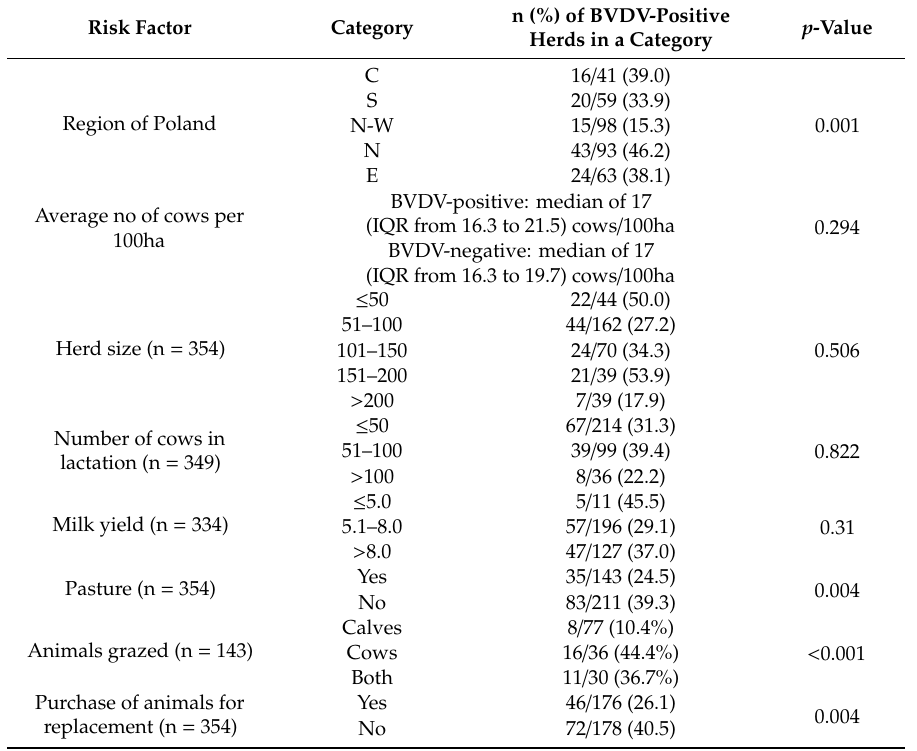
Table 3. Estimation of the factors considered to be a “risk” for the presence of BVDV at the herd level.